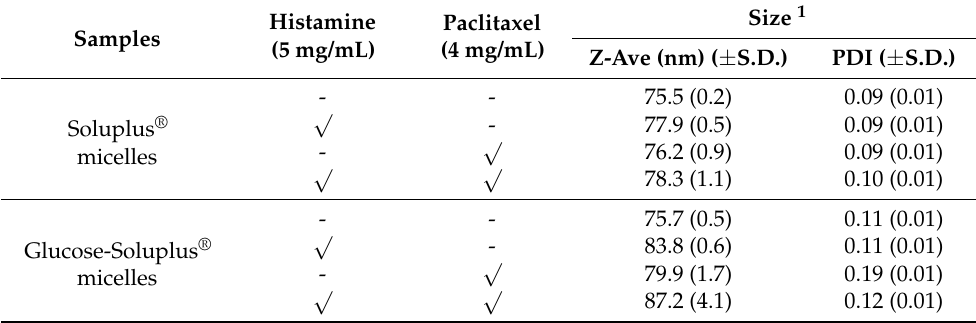
Table 1. Micellar size and size distribution (PDI) of free and drug-loaded Soluplus ® micelles (5% w / v ), in presence or absence of glucose, at 25 ◦